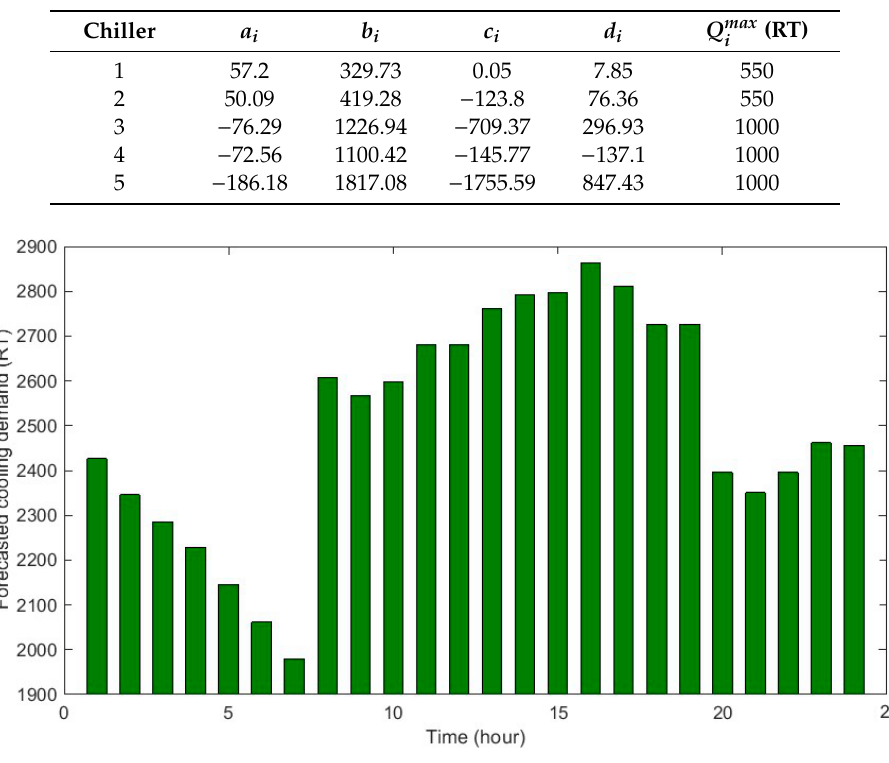
Figure 2. Forecasted value of cooling demand over a sample 24-h time interval.